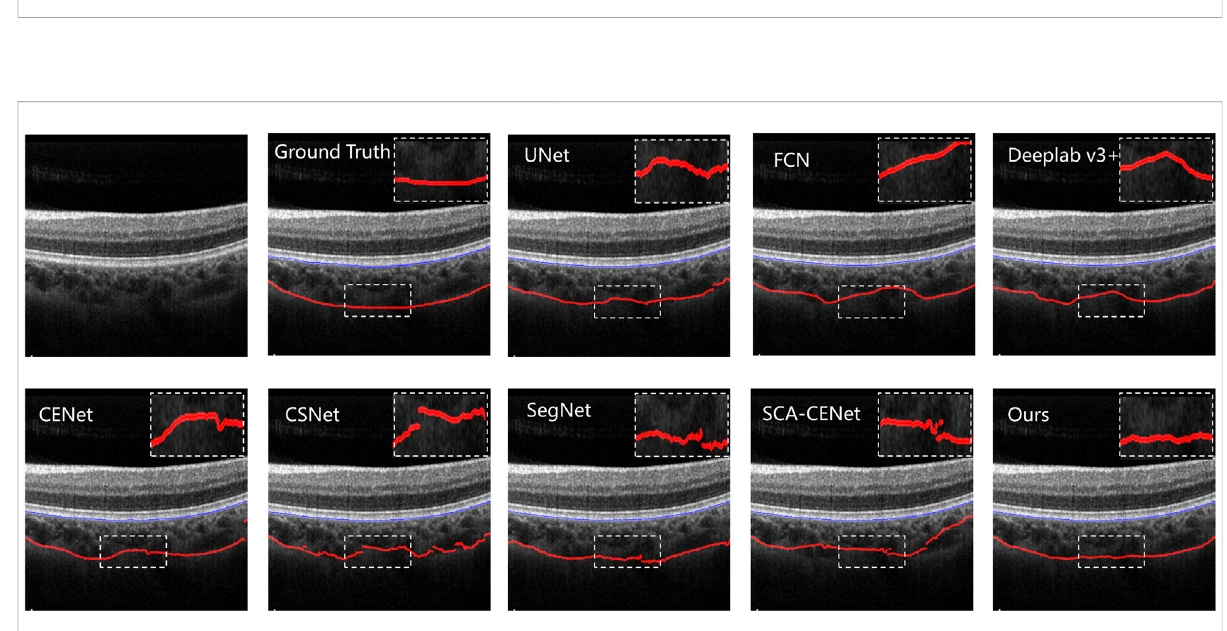
FIGURE 7 Results of different choroid segmentation methods in boundary detection. The name of the method is shown at the upper left corner of each image.